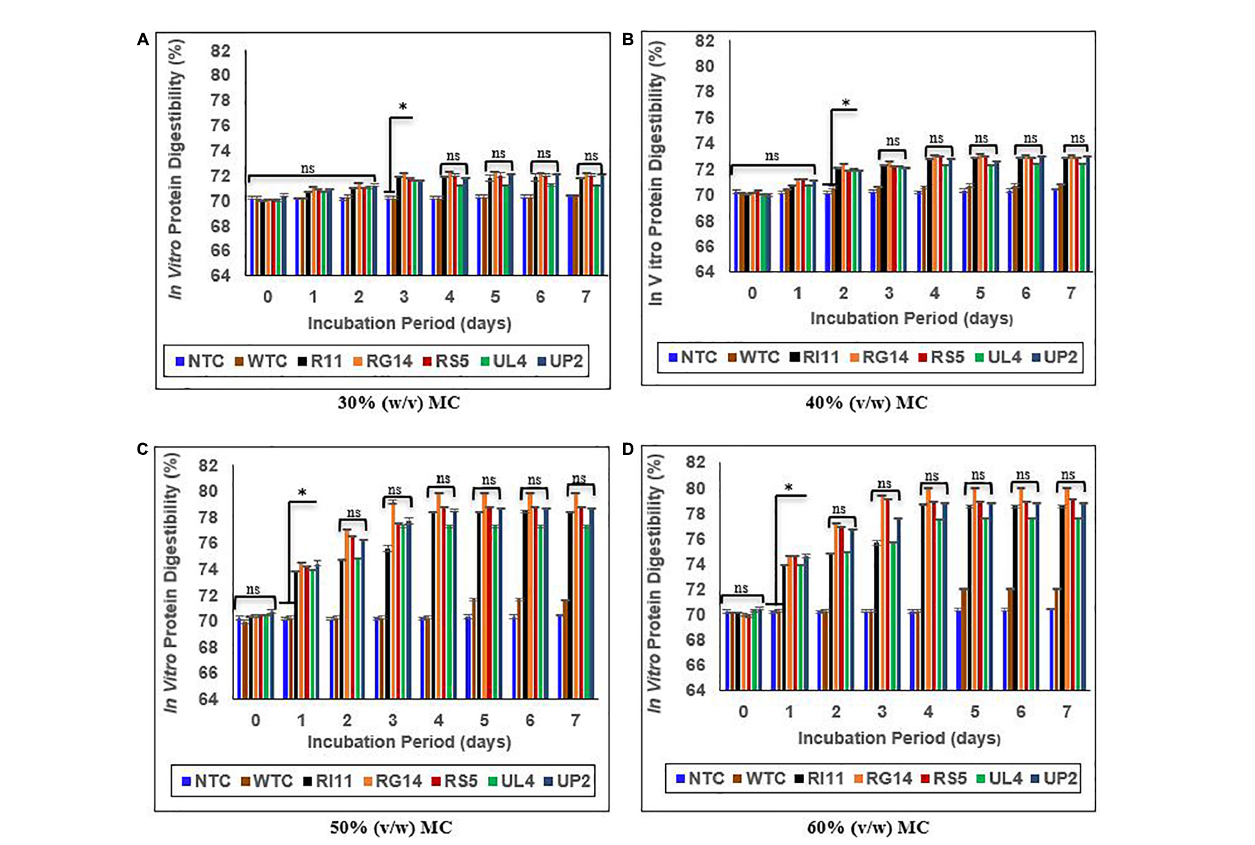
FIGURE5 Effect of moisture contents on in vitro protein digestibility of composite flour during 7 days of solid-state fermentation mediated by probiotic strains. Each value represents mean ± SEM, n = 3. NTC, non-treated control; WTC, water-treated control; R111, L. plantarum RI11; RG14; L. plantarum RG14; RS5, L. plantarum RS5; UL4, L. plantarum UL4; UP2, P. pentosaceus UP2. (A) 30% (v/w) moisture content, (B) 40% (v/w) moisture content, (C) 50% (v/w) moisture content, (D) 60% (v/w) moisture content. ∗ Indicate significant difference ( p ≤ 0.05). ns Not significantly